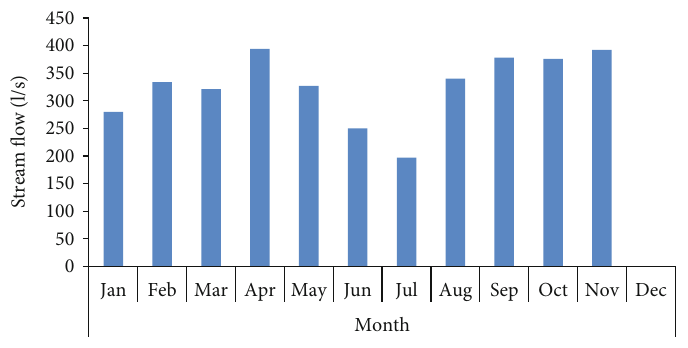
Figure 18: River fl ow levels of the nonnetworked hybrid PV-hydro minigrid system with storage.